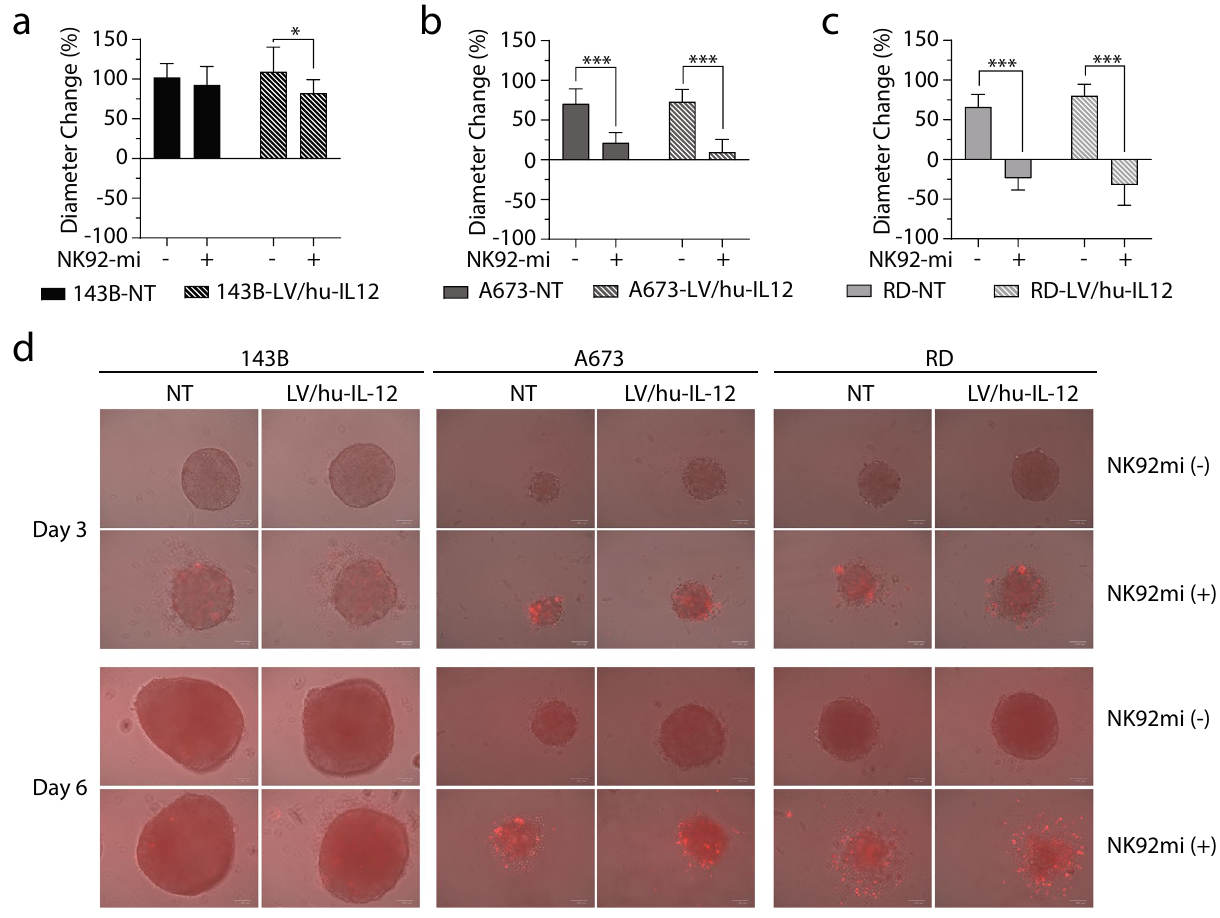
Figure 3. Non-transduced and LV/hu-IL-12 transduced human sarcoma lines for ( a ) osteosarcoma (143B), ( b ) Ewing sarcoma (A673), and ( c ) rhabdomyosarcoma (RD) were plated in ultralow adherent 96-well plates. After 48 h, spheroid formation was verified, diameters were recorded, and CTFR-labeled NK-92mi cells were added at a 1:1 ratio. Diameters were recorded every 24 h and displayed as Δ96 h. ( d ) Representative merged brightfield and red channel images. N = 8; 2 independent experiments, displayed mean ± standard deviation. * = p < 0.05, ** = p < 0.001, *** = p < 0.0001.